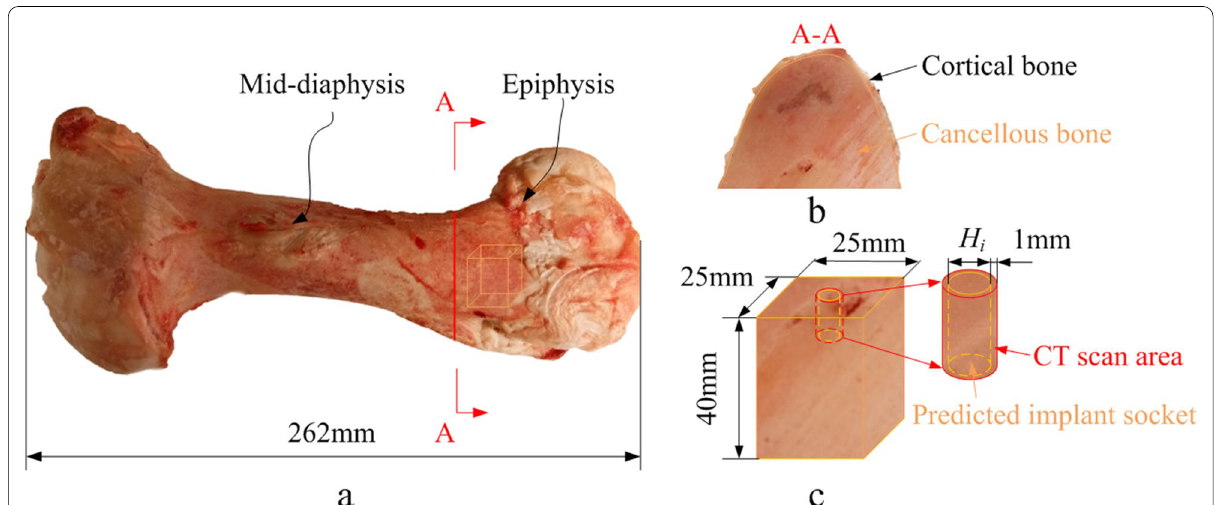
Figure 4 Preparation of bone blocks: a bovine femur, b A-A cross-section, the cortical bone and cancellous bone could be recognized in this cross-section, as cortical layer were so thin, therefore, it could be ignored in our research, c the bone blocks used in experiments and the CT scan area (CT scan area was defined within 1 mm around the predicted implant